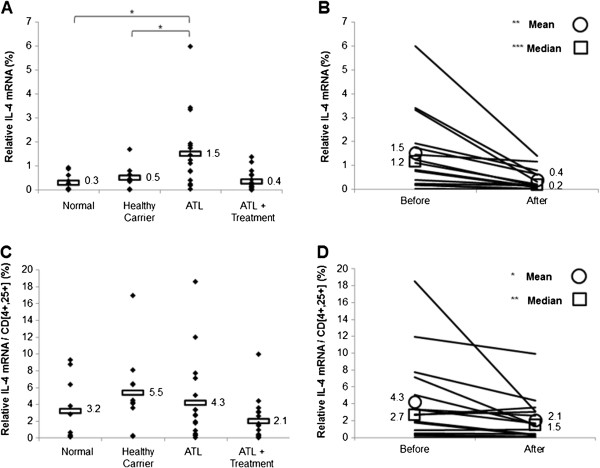
Treatment with arsenic/IFN/zidovudine decreased IL-4 expression. A. IL-4 transcript levels in normal blood donors (n=10), healthy carriers of HTLV-I (n=10) and ATL patients (n=16) at initiation and 30 days after treatment with arsenic/IFN/zidovudine. Rectangles represent mean values. B. Mean and median IL-4 transcript levels of individual ATL patients at initiation and 30 days after treatment with arsenic/IFN/zidovudine. C, D. Relative expression of IL-4 transcripts after normalization to the number of CD4+CD25+ ATL cells. All values are expressed as percentage of human beta2-microglobulin used as internal control. *, **, *** indicate p values less than 0.05, 0.01 and 0.001 respectively.